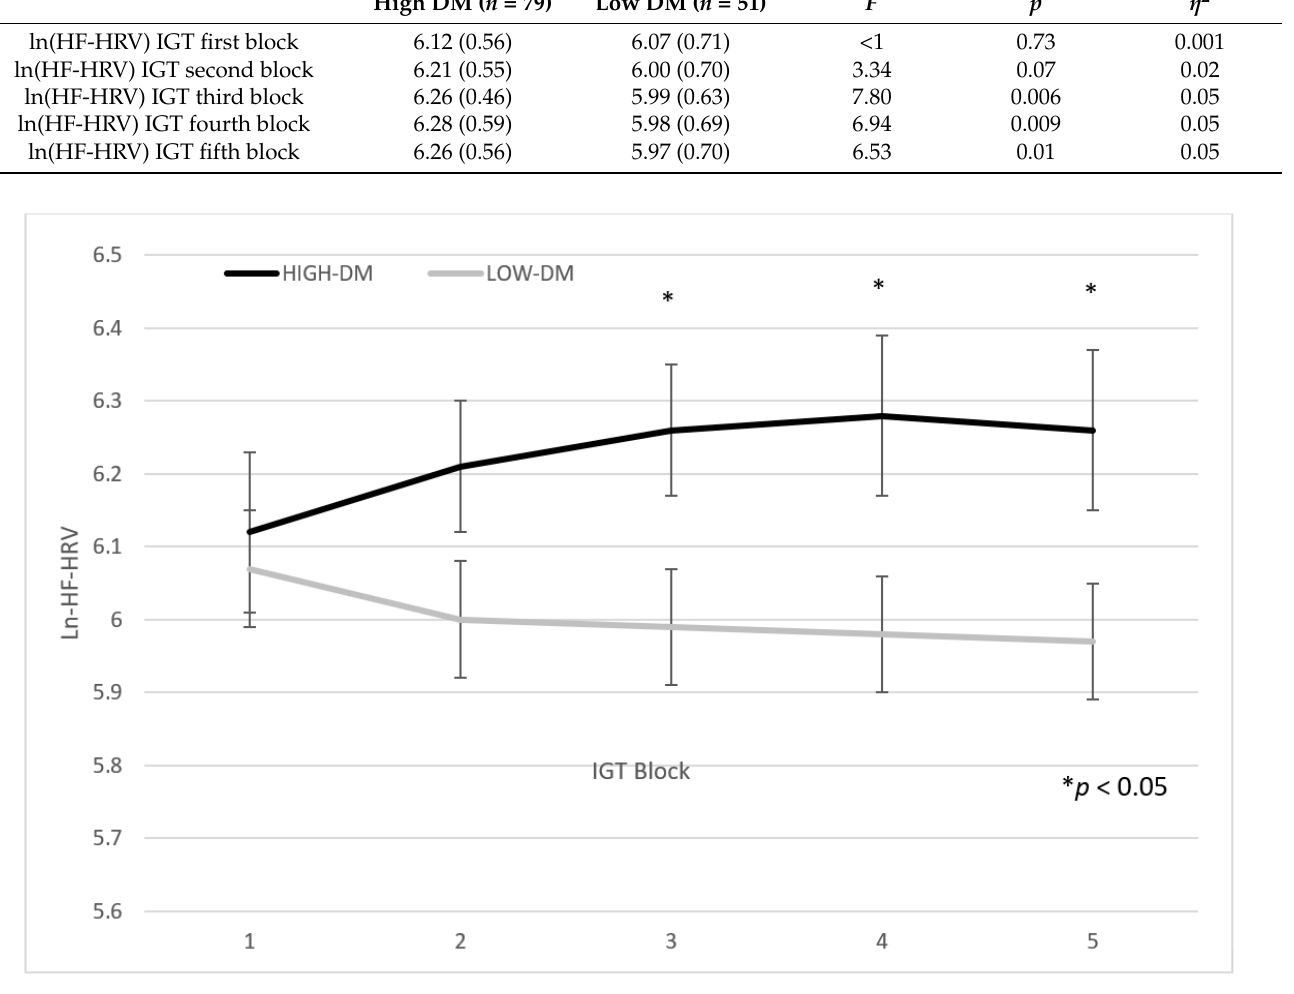
Figure 2. ln(HF-HRV) trend during Iowa Gambling Task of high and low decision-makers. HF: High Frequency; IGT: Iowa Gambling Task; DM: Decision